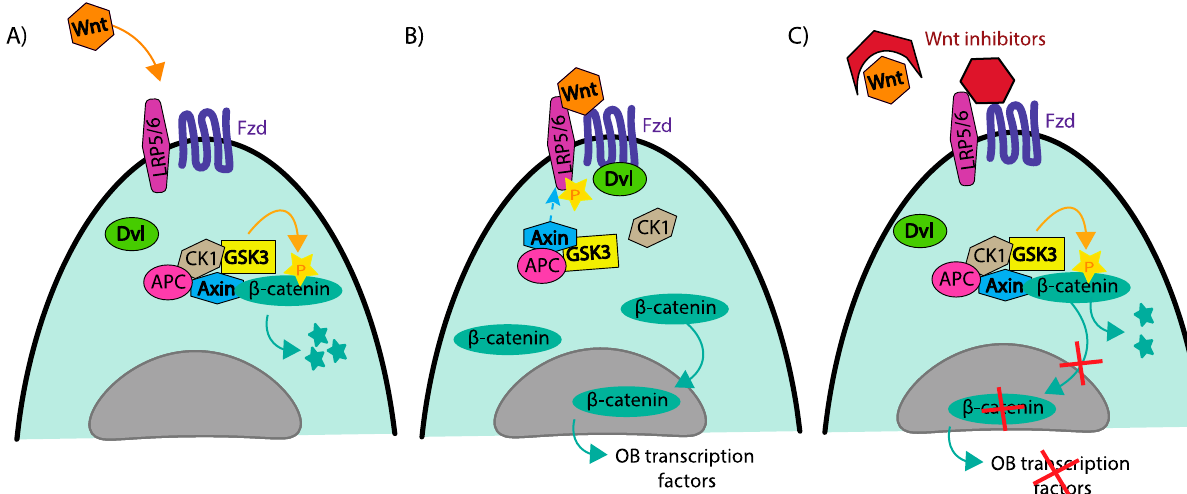
Figure 3. Canonical Wnt signalling in myeloma bone disease: ( A ) when canonical Wnt signalling is inactive, a destruction complex (including Axin, glycogen synthase kinase 3 (GSK3), adenomatous polyposis coli (APC), and casein kinase 1 α (CK1 α )) is responsible for continual phosphorylation and destruction of β -catenin. ( B ) When Wnt ligands bind to Wnt receptor Fzd and co-receptor LRP5/6, LRP5/6 becomes phosphorylated, which leads to recruitment of Dishevelled (Dvl), and, subsequently, Axin and GSK3 to the receptor complex [53]. As a result, there is a breakdown in the destruction complex. This leads to an increase in β -catenin translocation to the nucleus (due to downregulated phosphorylation), resulting in expression of OB transcription factors, and promotion of OB secretion of OPG [59,72]. ( C ) In MM, upregulated levels of Wnt inhibitors (red) antagonise Wnt either directly or indirectly (such as binding LRP5/6), leading to the downregulation of OB transcription factor expression.